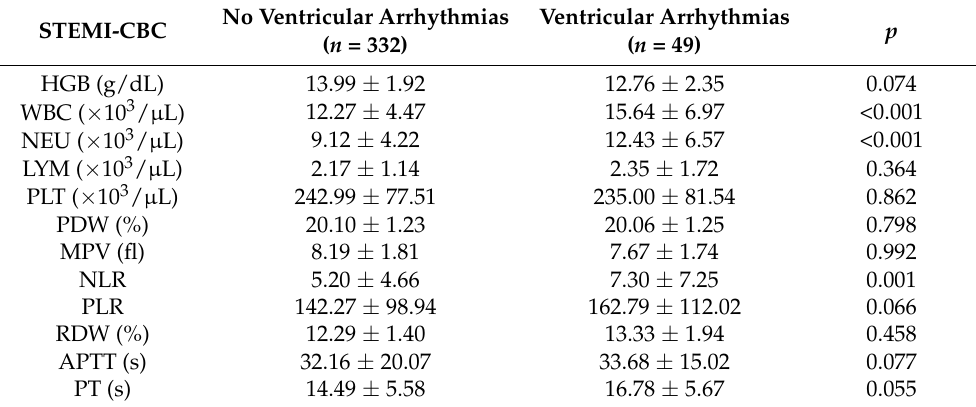
Table 9. Hematological and coagulation parameters of the groups with/without ventricular arrhyth- mias in STEMI patients. STEMI-CBC